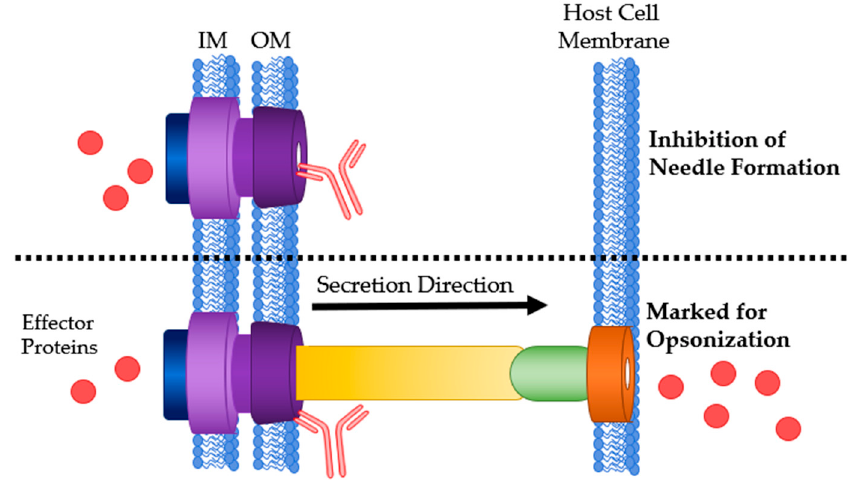
Figure 6. Mechanisms of Ab interaction with the T3SS basal body. Top : Ab bound to the outer membrane ring of the T3SS basal body preventing needle formation. Bottom : Ab bound to the basal body marking it for opsonization or ADCC. IM: bacterial inner membrane; OM: bacterial outer membrane.